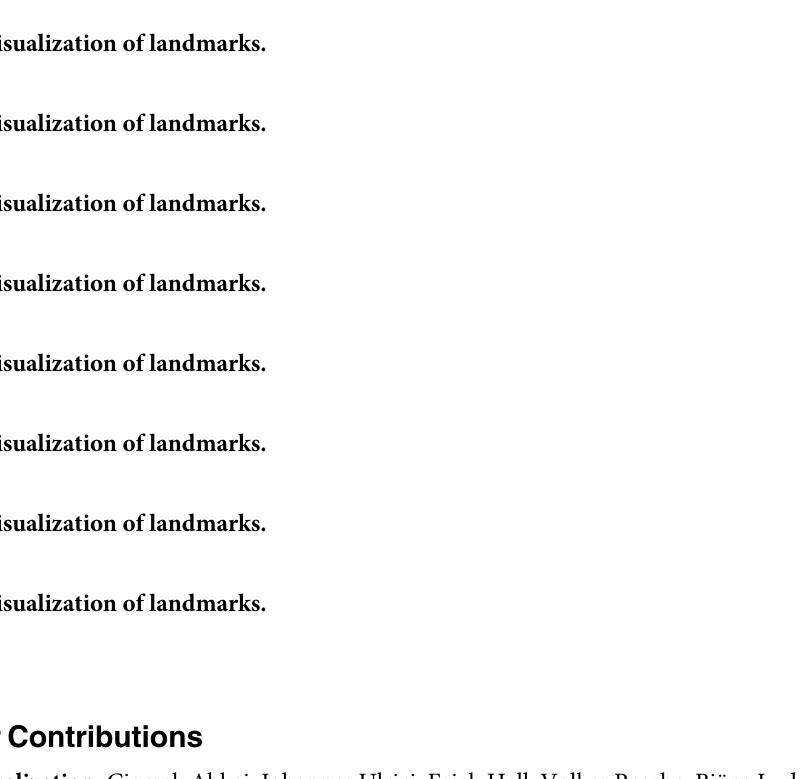
S1 Fig. Visualization of landmarks. S2 Fig. Visualization of landmarks. S3 Fig. Visualization of landmarks. S4 Fig. Visualization of landmarks. S5 Fig. Visualization of landmarks. S6 Fig. Visualization of landmarks. S7 Fig. Visualization of landmarks. S8 Fig. Visualization of